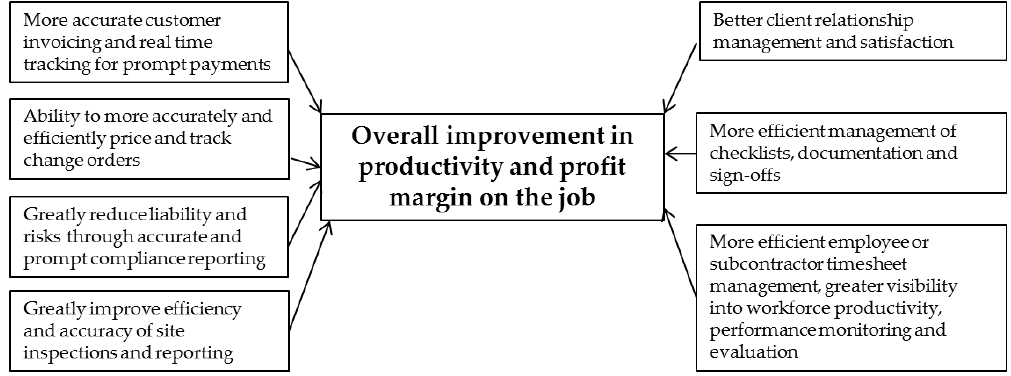
Figure 1. Conceptual Model: Benefits of Apps and Overall Productivity